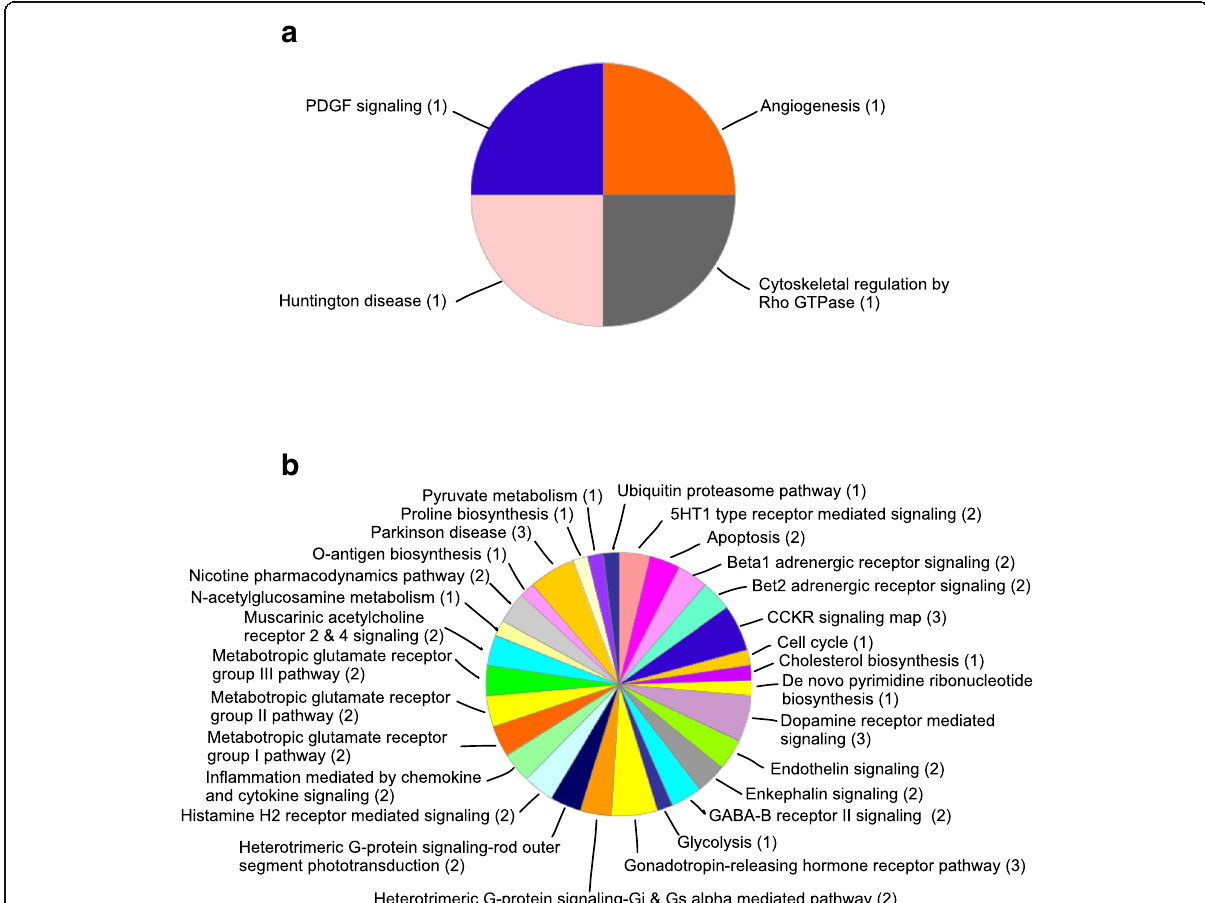
Fig. 2 Distribution of pathways based on Panther Classification System. Pathways related to differentially expressed proteins in ( a ) young versus senescent cells and ( b ) vehicle- versus γ T3-treated senescent cells. The number in bracket indicates number of